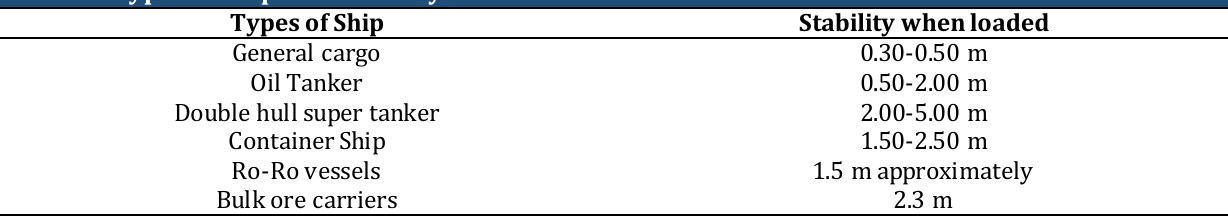
Table 1: Types of ship and stability